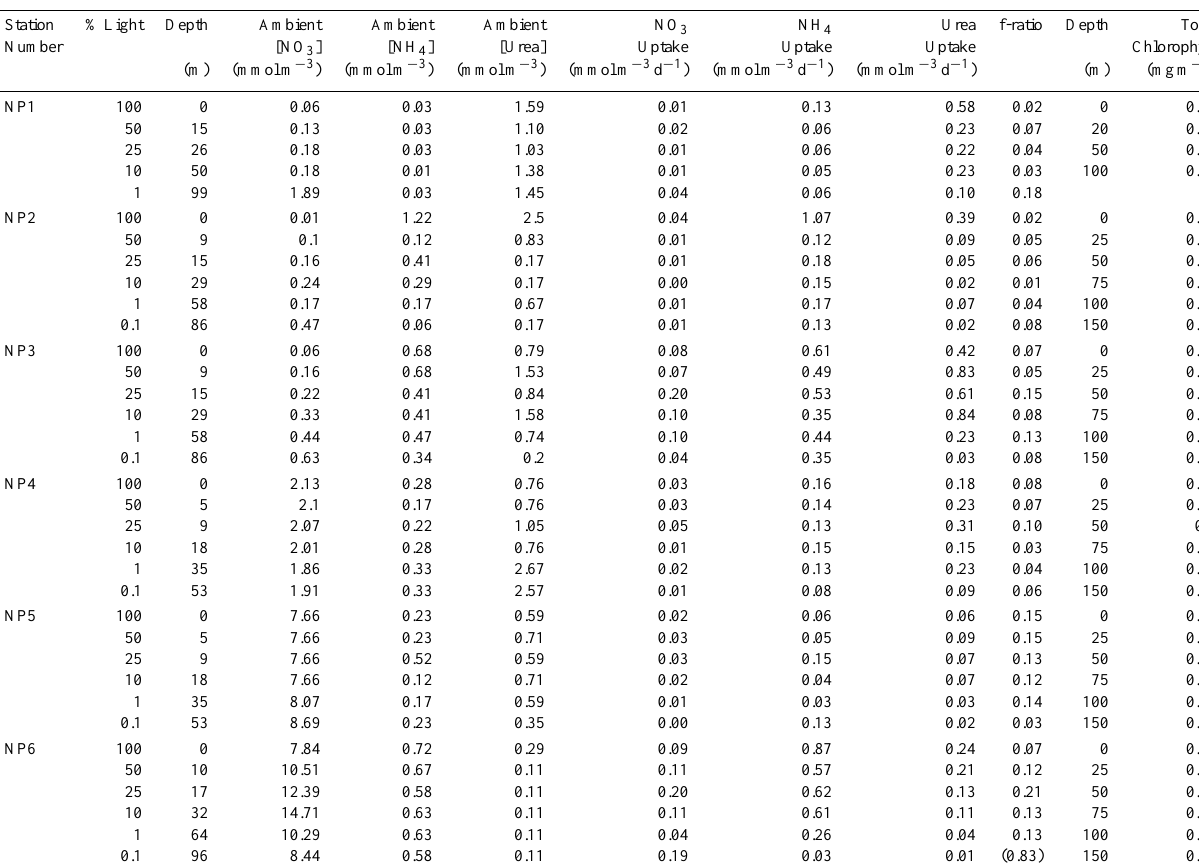
Table 1. Nitrate, ammonium and urea concentrations (mmolm − 3 ) , uptake rates (mmolm − 3 d − 1 ) and f-ratios at the various light depths for the productivity stations of the Southbound Transect, together with total chlorophyll (mgm − 3 ) at set depths in the top 150m.